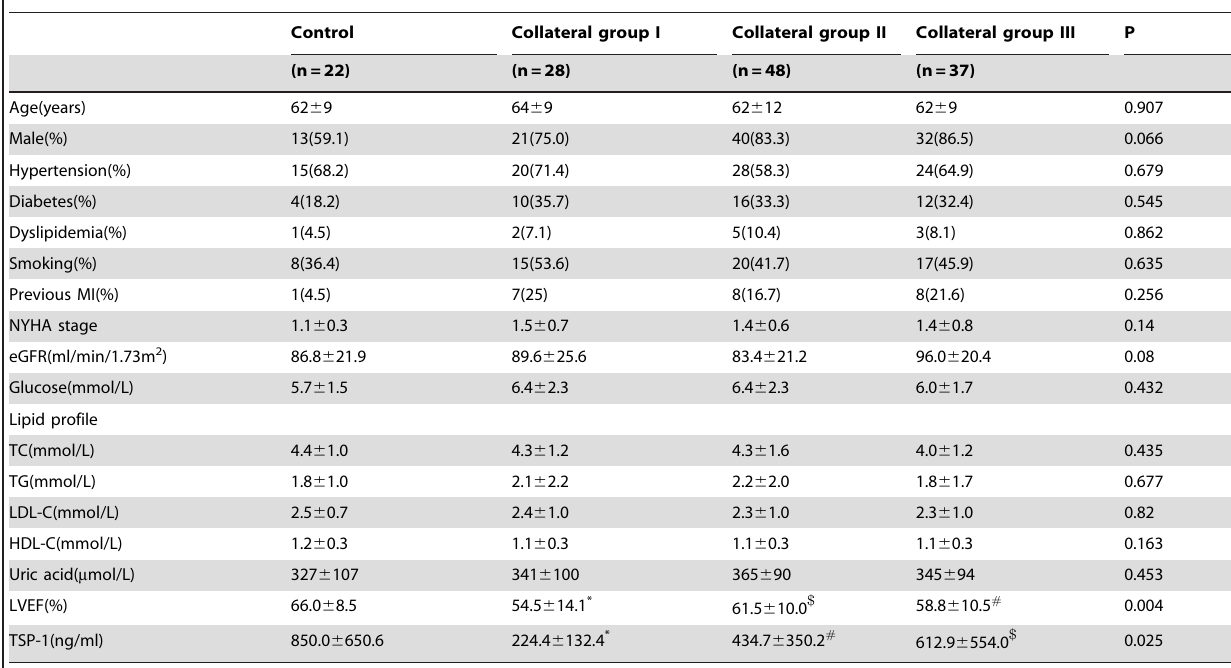
Table 1. Clinical characteristics and serum TSP-1 level in all